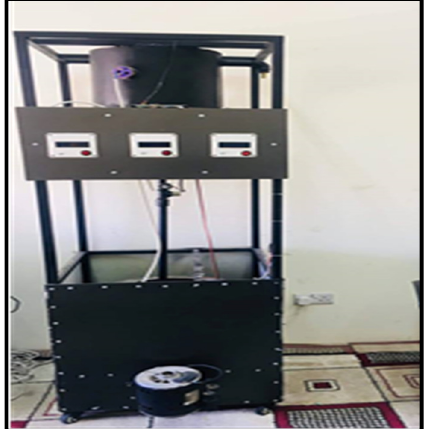
Fig. 3. Final Hardware